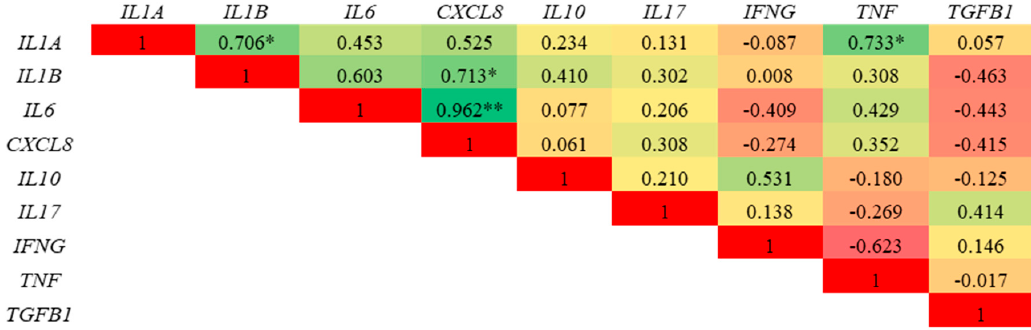
Figure 6. Correlation analysis of a selected panel of cytokine genes in porcine colonic tissue explants stimulated by LPS, 3 h post-incubation. Each value corresponds to the correlation coefficient of the corresponding genes. * p < 0.05 and ** p < 0.01.